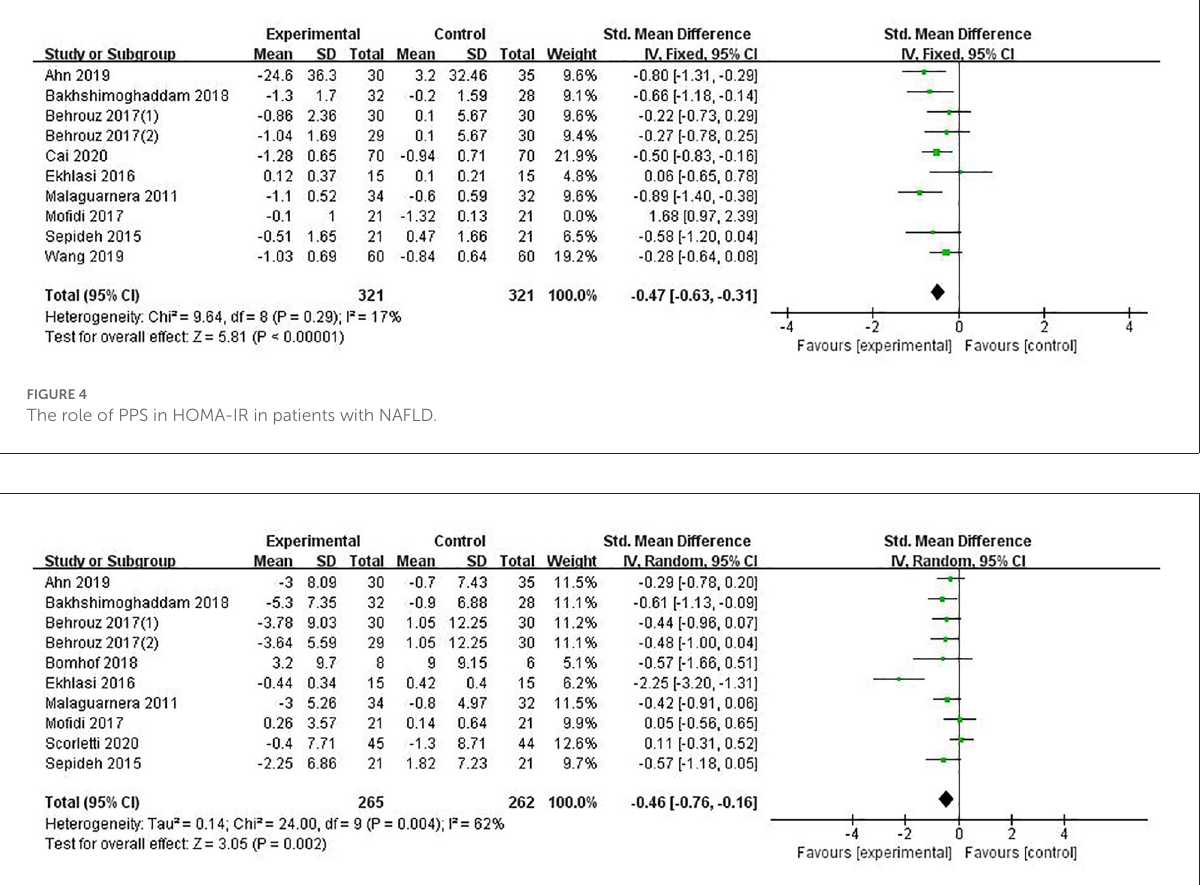
FIGURE5 The role of PPS in Insulin in patients with